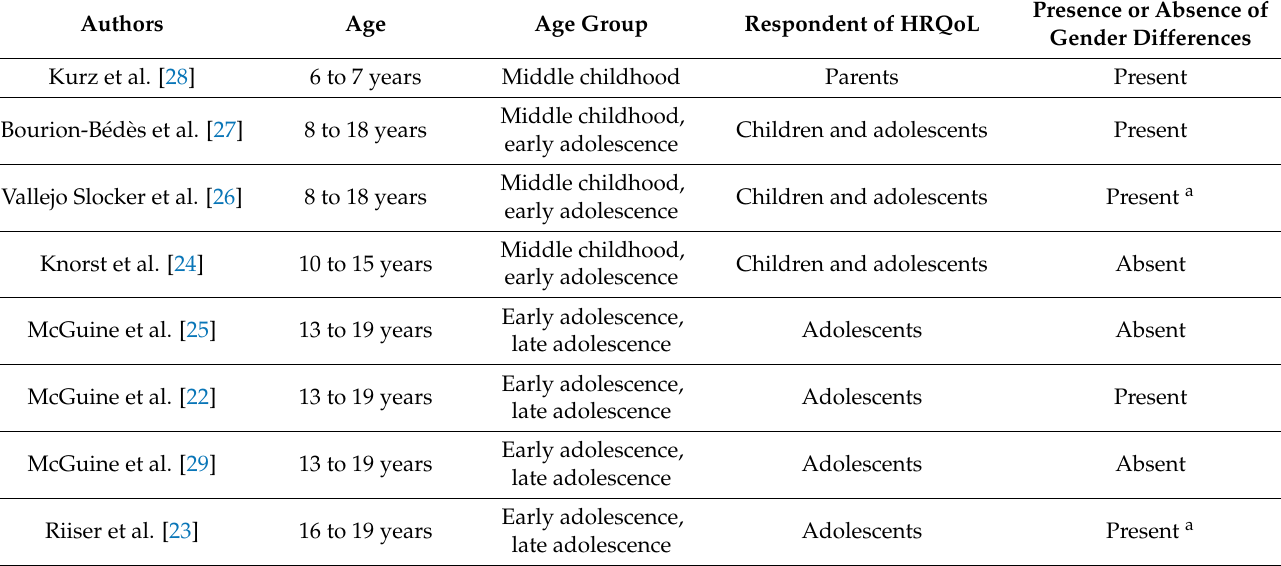
Table 2. Results of the respondent types in the included HRQoL studies ( n =